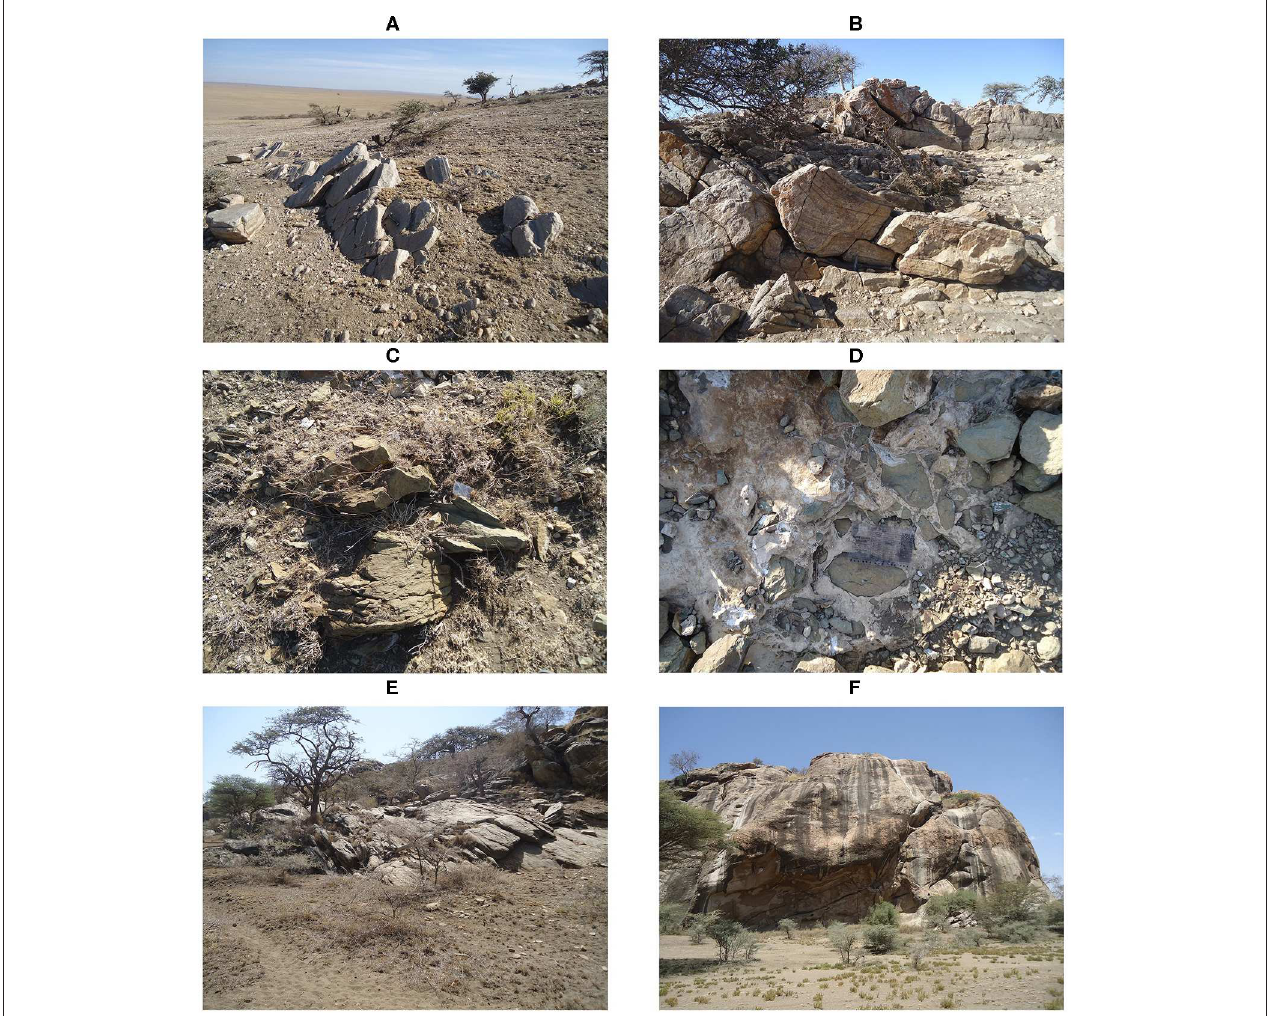
FIGURE 2 | Endonyo Osunyai: (A) Quartzites with foliation planes dipping south; (B) fractured gneiss outcrops showing one asymmetrical fold with harmonic folding; Engelosin: (C) weathered, oxidized, and fractured phonolite; (D) talus accumulations of phonolitic breccia cemented by calcrete; Gol Mountains: (E) west of Kesile, complexly deformed and exfoliated north-south trending granite gneiss outcrop with steeply-dipping foliation planes; (F) view south toward the rockshelter at Soit Nasera, a quartz-feldspathic monolith.